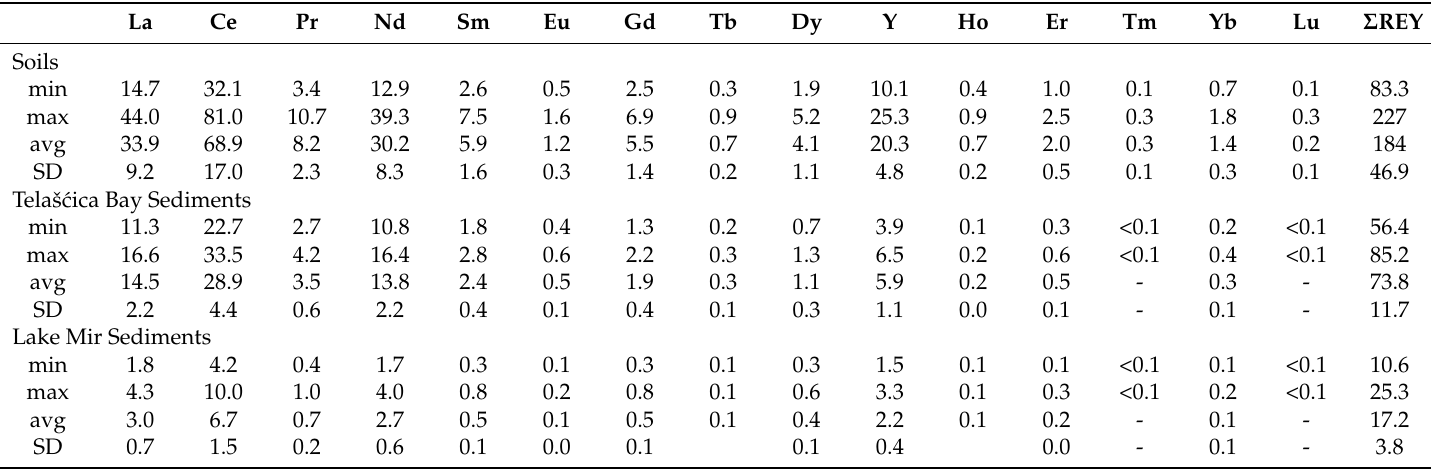
Table 1. Basic descriptive statistical parameters for distribution of rare earth elements and Y concentrations, expressed in mg kg − 1 , in the Lake Mir and the Telaš´cica Bay sediments and